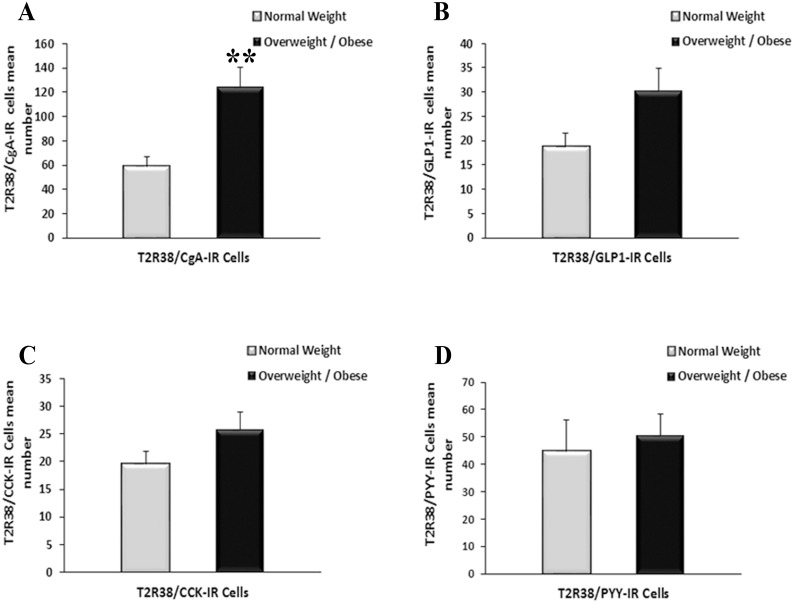
Density of T2R38 subpopulations of EEC cells in NW and OW/OB subjects.(A) Density of T2R38/CgA-IR cells in NW compared to OW/OB subjects. (B-D) Density of T2R38/GLP-1-IR (B), T2R38/CCK-IR (C) and T2R38/PYY-IR (D) cells in NW and OW/OB subjects. All data are expressed as mean ± SEM. ** indicate a statistically significant difference, P = 0.01 between NW and OW/OB groups.